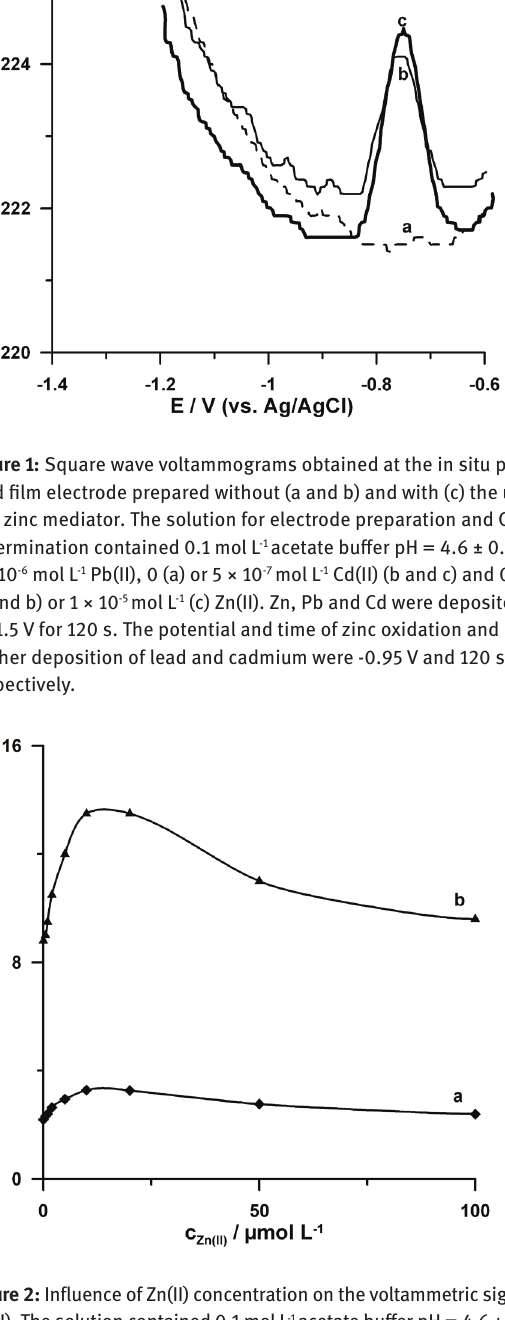
attained a maximum and stable value as lead, zinc and